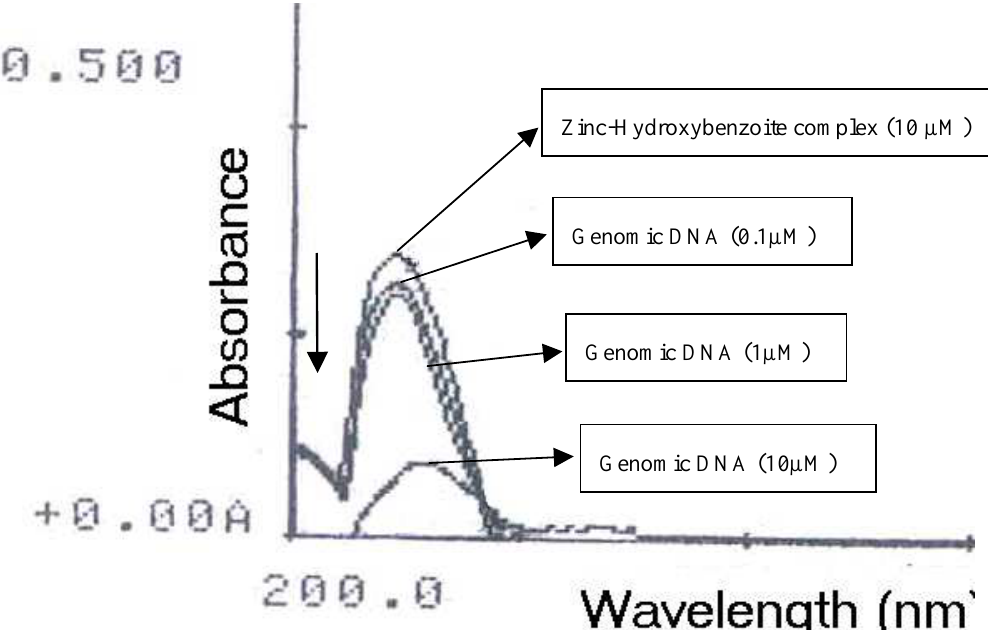
Figure 2. Absorption spectra of Zinc-Hydroxybenzoite complex (10 µM) in the absence (top) and presence of genomic DNA (0.1µM, 1µM, and 10µM). Arrow (thick) shows that the absorbance changes upon increasing DNA